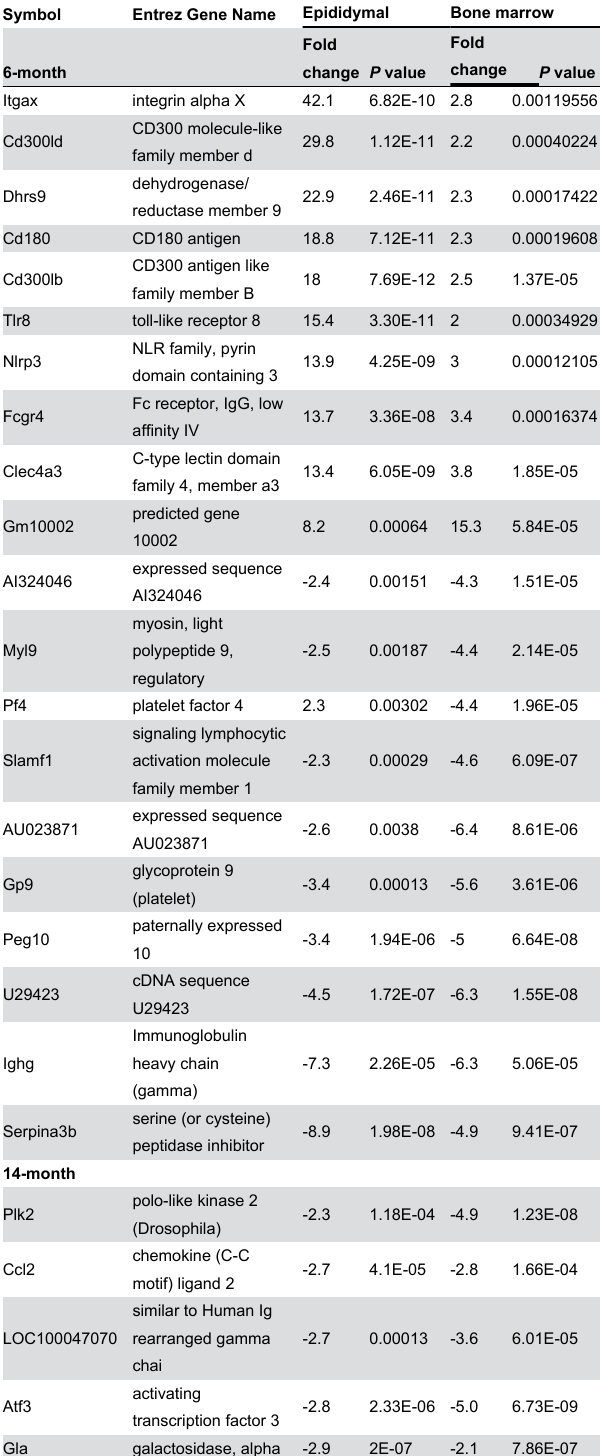
Table 7. Genes highly up- and down-regulated by a high fat diet that are common to both epididymal and bone marrow